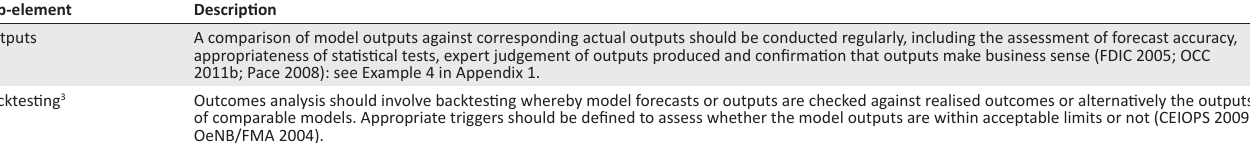
TABLE 3: Outcome